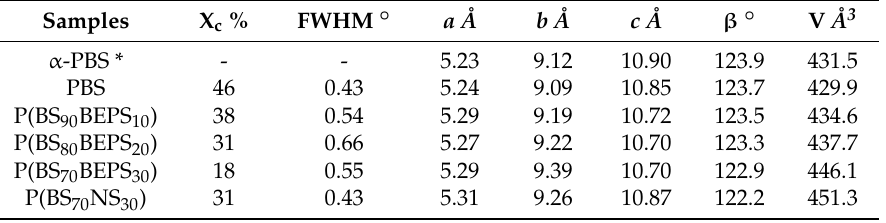
Table 3. Crystallinity index (X c ), width of the 0 2 0 peak (FWHM) and unit cell parameters.